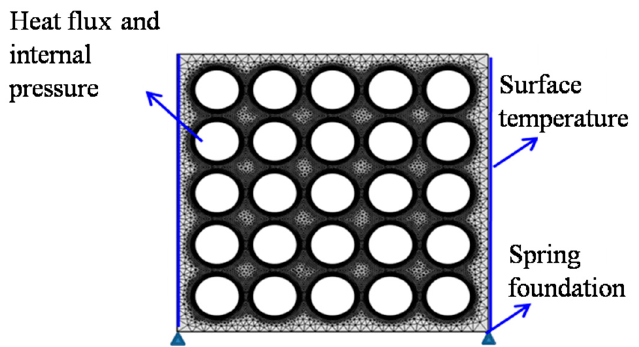
Figure 4. Two-dimensional model of the FCM pellet; the structure and boundery condition were also revealed.